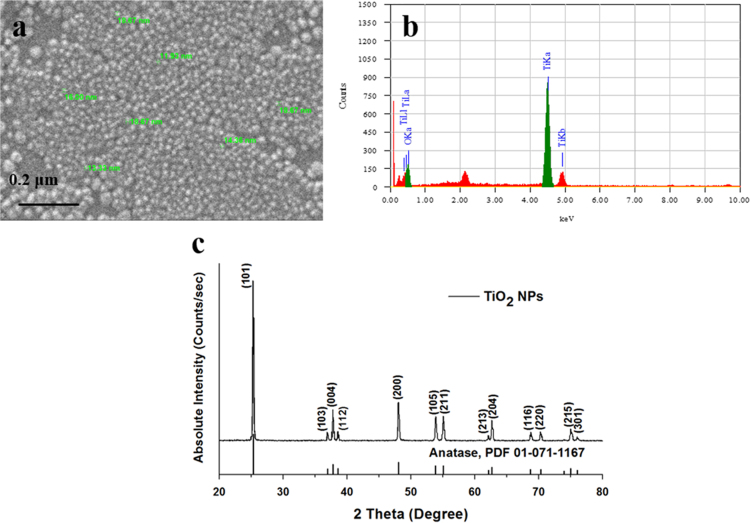
Characterization results of TiO2 NPs. (a) SEM image, (b) EDX and, (c) XRD spectrum of TiO2 NPs.